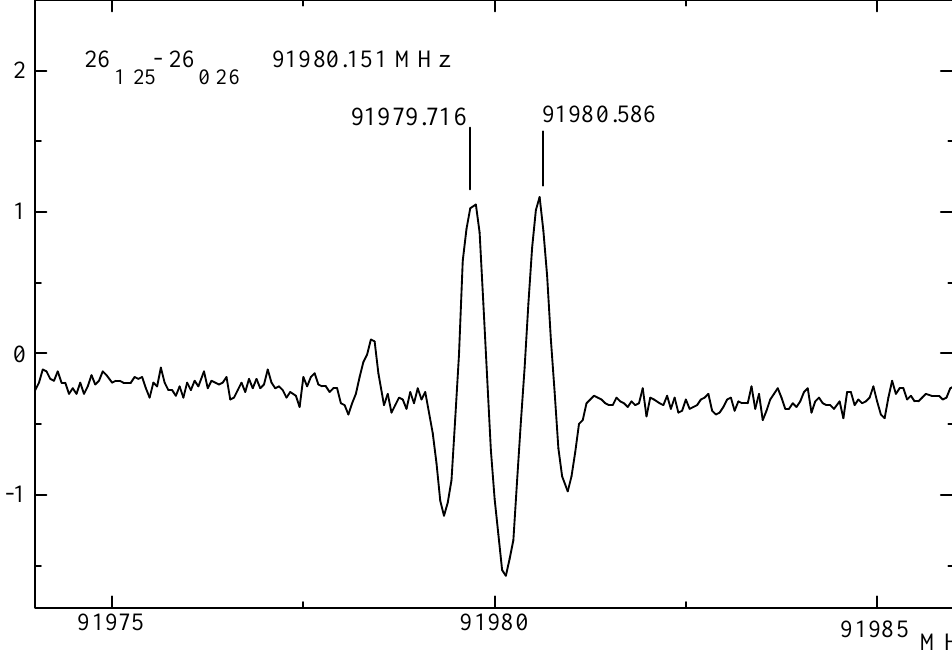
Figure 3. Absorption line for the 26